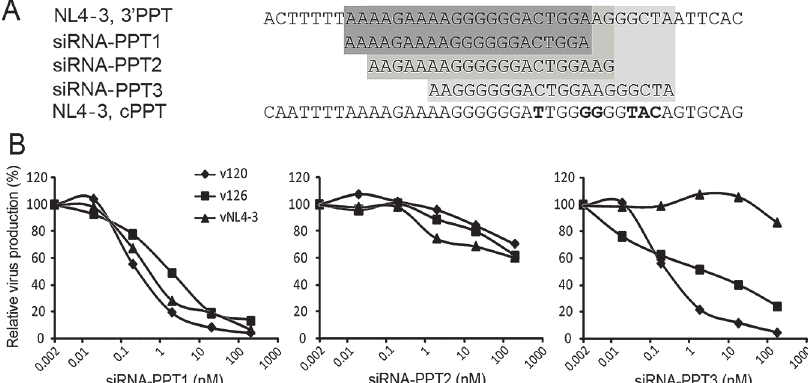
Fig 1. Design of siRNA-ppts and measuring their inhibition of HIV-1 replication. (A) Three siRNAs were designed to target the HIV-1 3 0 PPT region: siRNA-PPT1, siRNA-PPT2 and siRNA-PPT3 contain sequence matching nt9069-9089, nt9071-9091, and nt9076-9096 of HXB2, respectively. The sense, passenger strands of the respective siRNA duplexes are indicated and aligned with the corresponding 3 ’ PPT and flanking sequences of NL4-3. Importantly, the targeted sequences within NL4-3, v120 and v126 virus strains are identical. (B) The efficiency of siRNA-PPT inhibition of HIV replication was monitored by RT activity